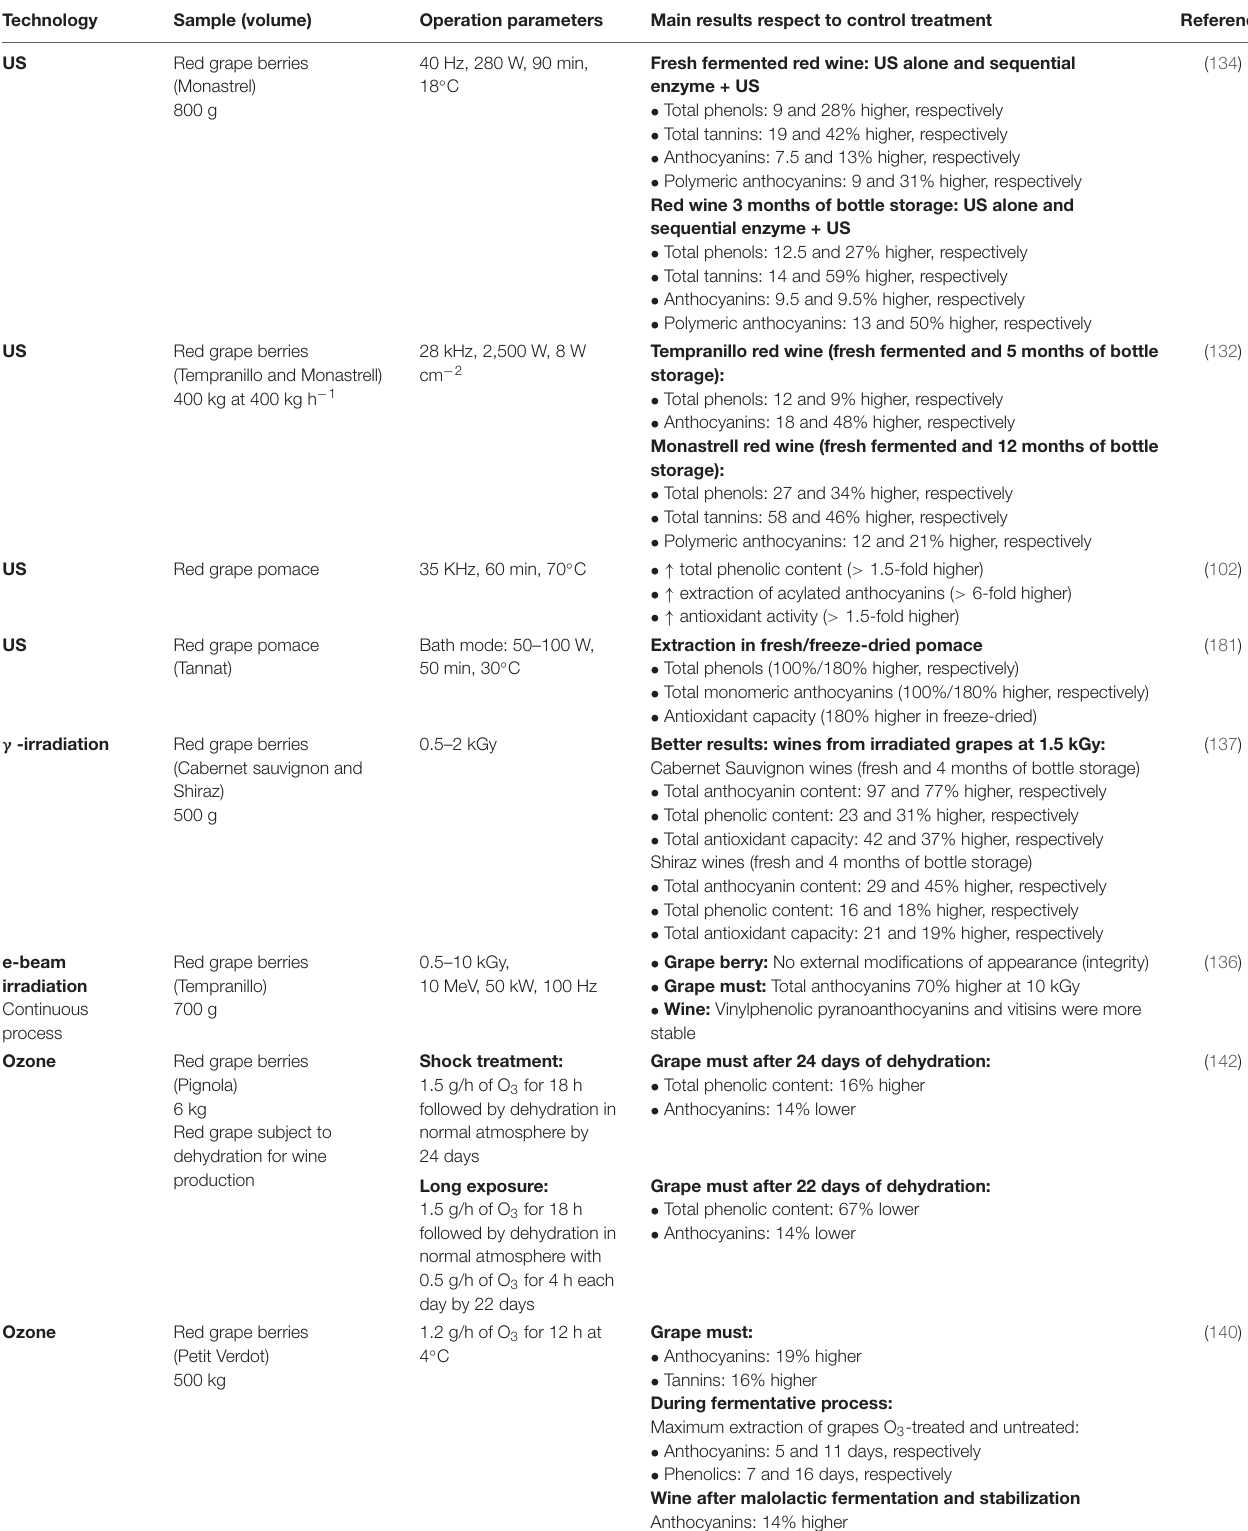
TABLE 4 | Applications of ultrasound and irradiation to improve the extraction of phenolic compounds during red winemaking. Technology Sample (volume) Operation parameters Main results respect to control treatment